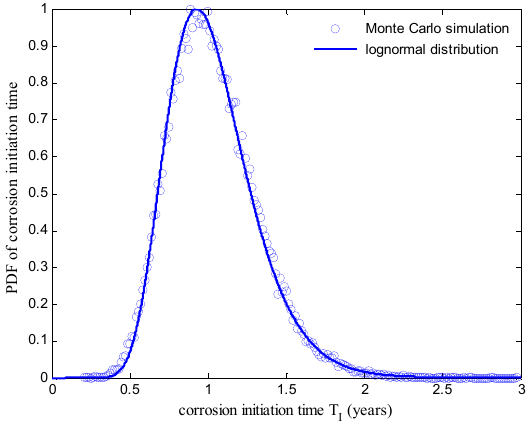
Figure 3. PDFs of the corrosion initiation time T 1.